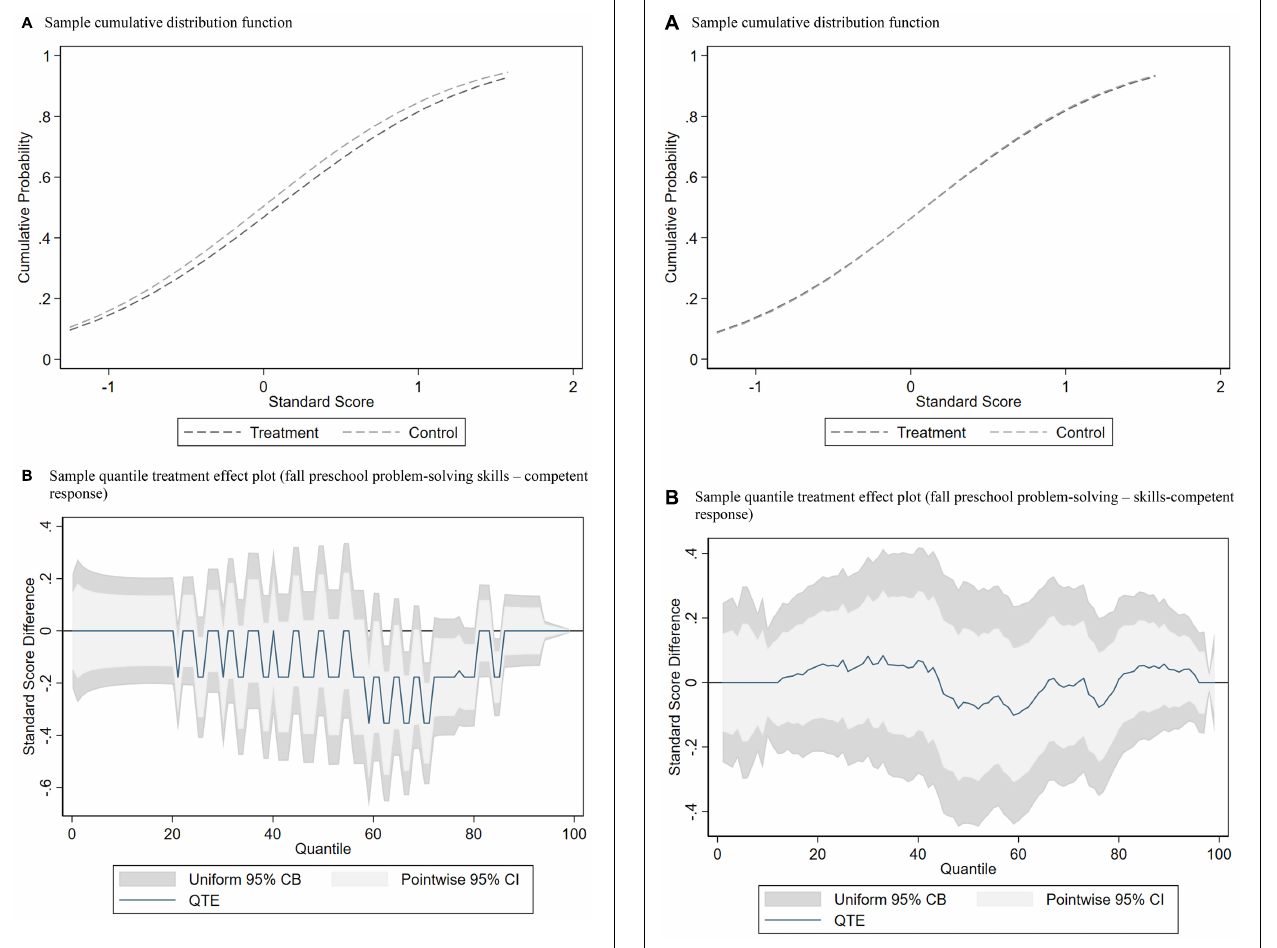
FIGURE 2 | Example of balance across treatment and control achieved from inverse propensity score weighting of distributions for comparison of socio-emotional curricula classrooms compared with business-as-usual classrooms on social problem-solving skills (competent response) standard scores at baseline (fall). (A) Sample cumulative distribution function. (B) Sample quantile treatment effect plot (fall preschool problem-solving – skills-competent